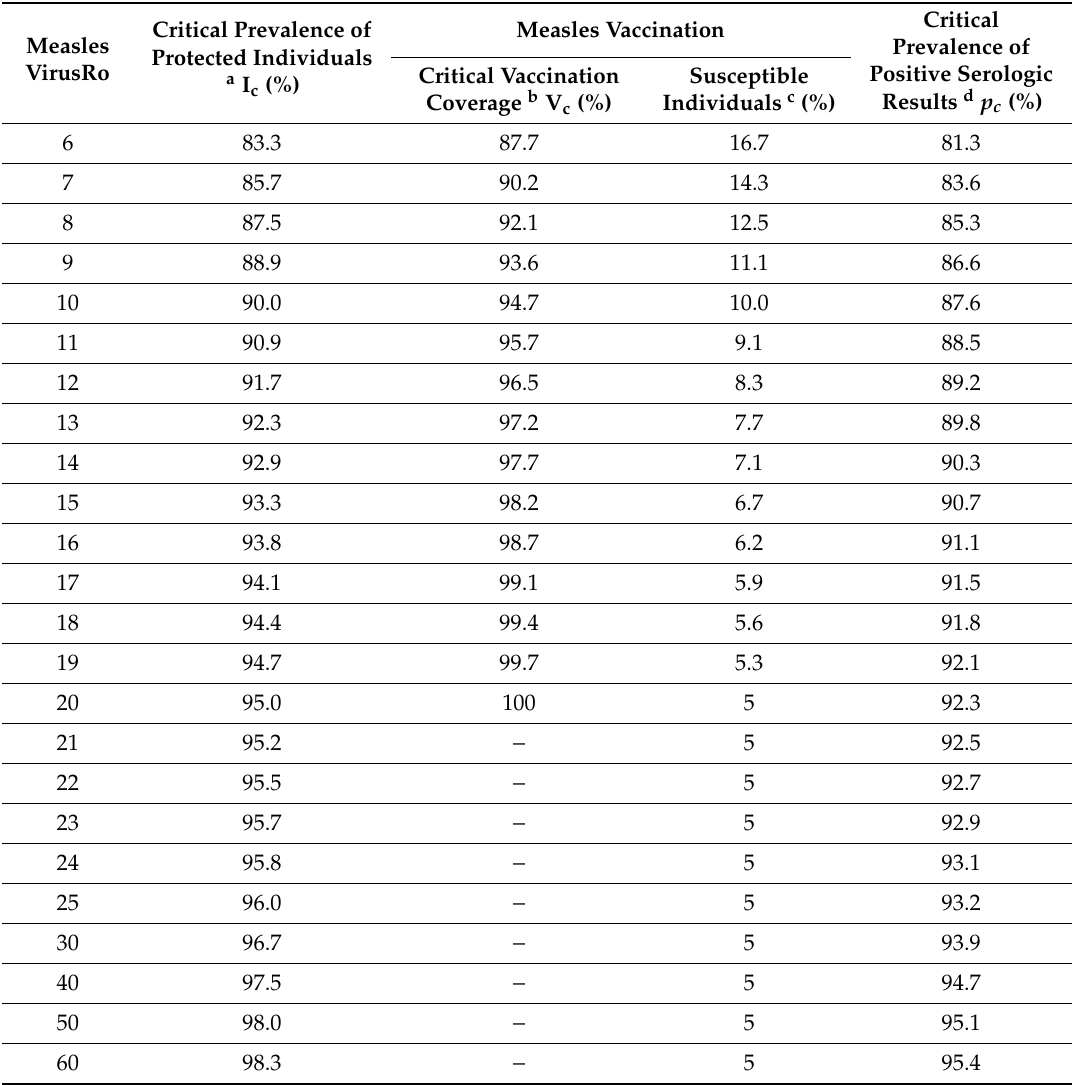
Table 2. Herd immunity thresholds in terms of the critical prevalence of protected individuals (I c ), critical vaccination coverage (V c ), the percentage of susceptible individuals in vaccinated populations, and the critical prevalence of positive anti-measles serologic results ( p c ) for measles viruses with basic reproductive numbers (Ro) ranging from 6 to